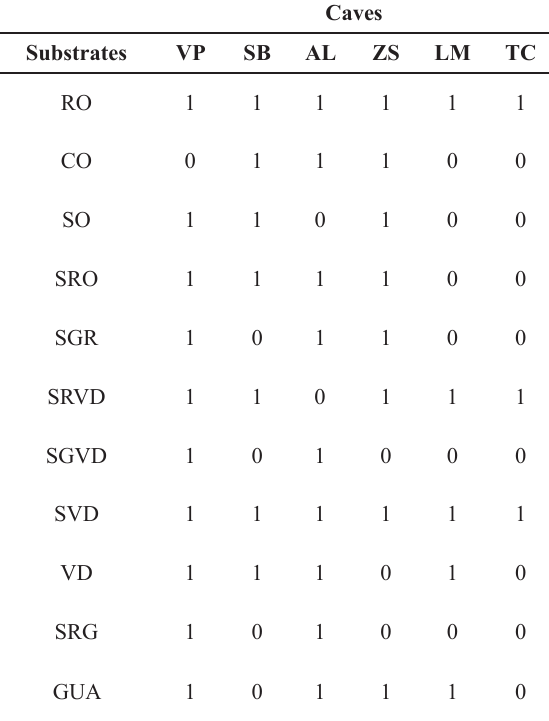
Substrates categories present in the sampling sites of the